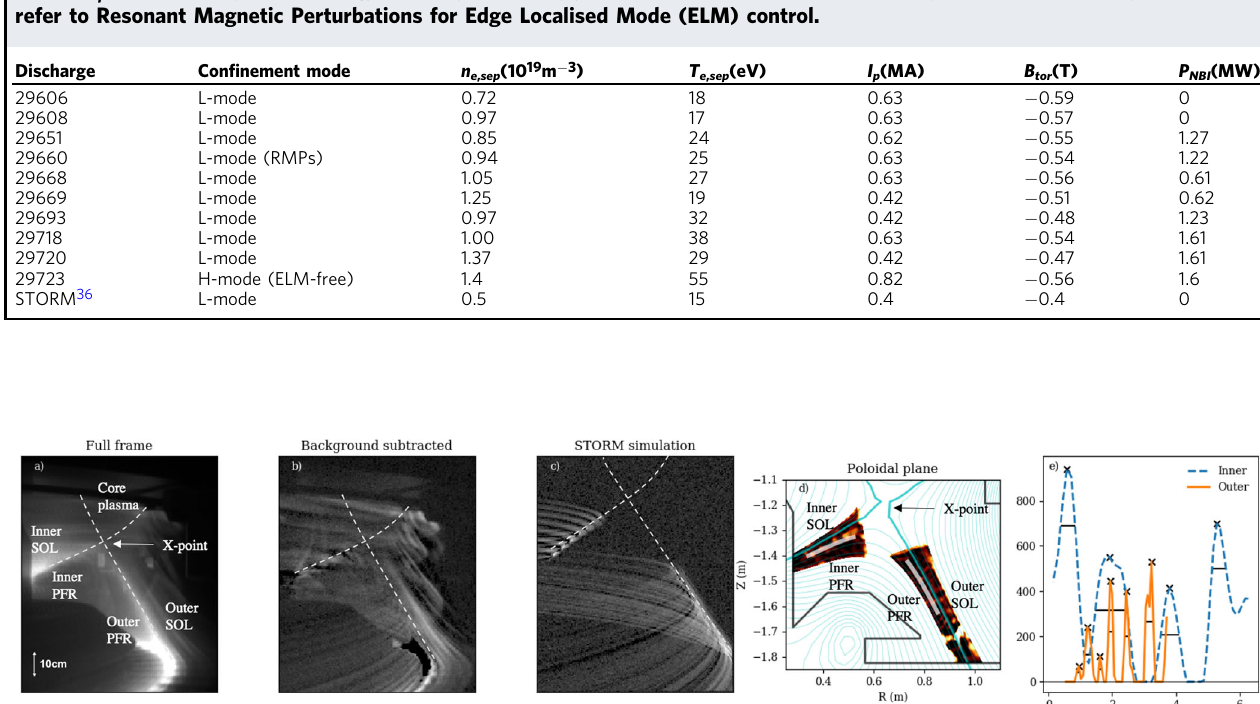
COMMUNICATIONS PHYSICS| (2022) 5:139